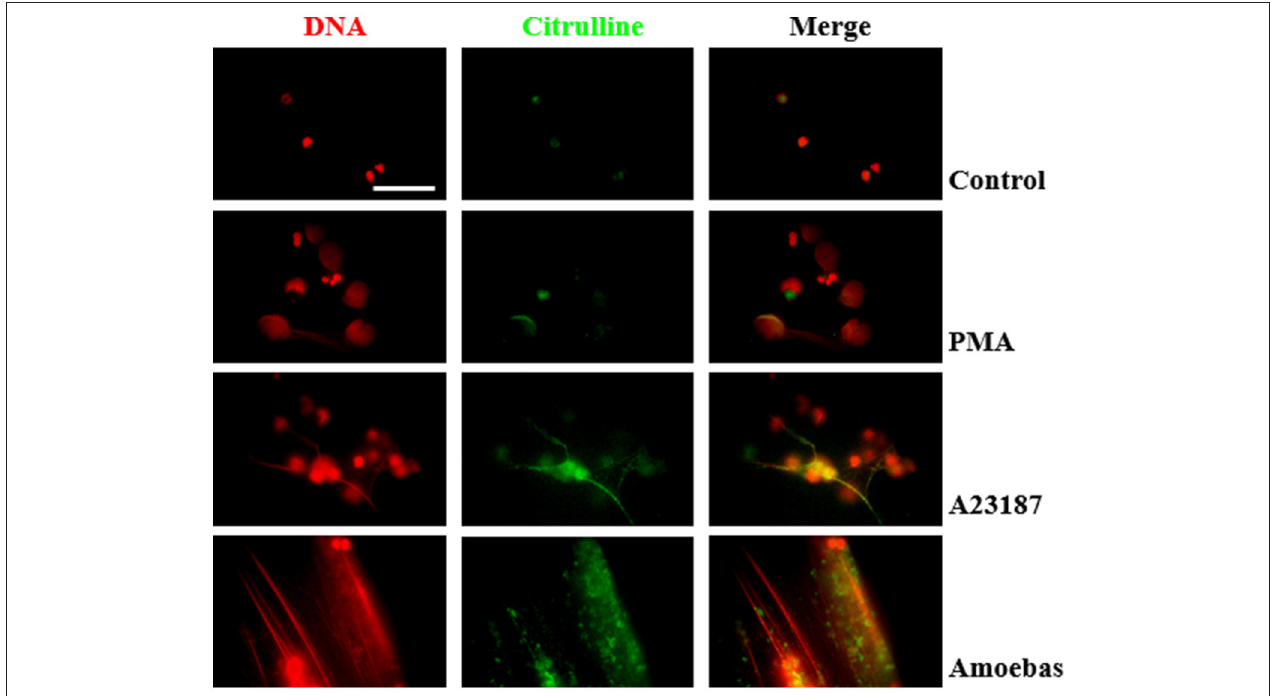
FIGURE 13 | Protein citrullination occurs during NET release induce by E. histolytica trophozoites. Non-stimulated neutrophil (2 × 10 5 ) and neutrophils stimulated with 20nM PMA, 10 µ M A23187 or co-cultured with 1 × 10 4 trophozoites during 4h were fixed and immunofluorescence performed using anti-citrulline antibody and anti-rabbit IgG conjugated to TRITC. DNA was staining with DAPI. Images were taken at 100x magnification. Scale bar 50 µ